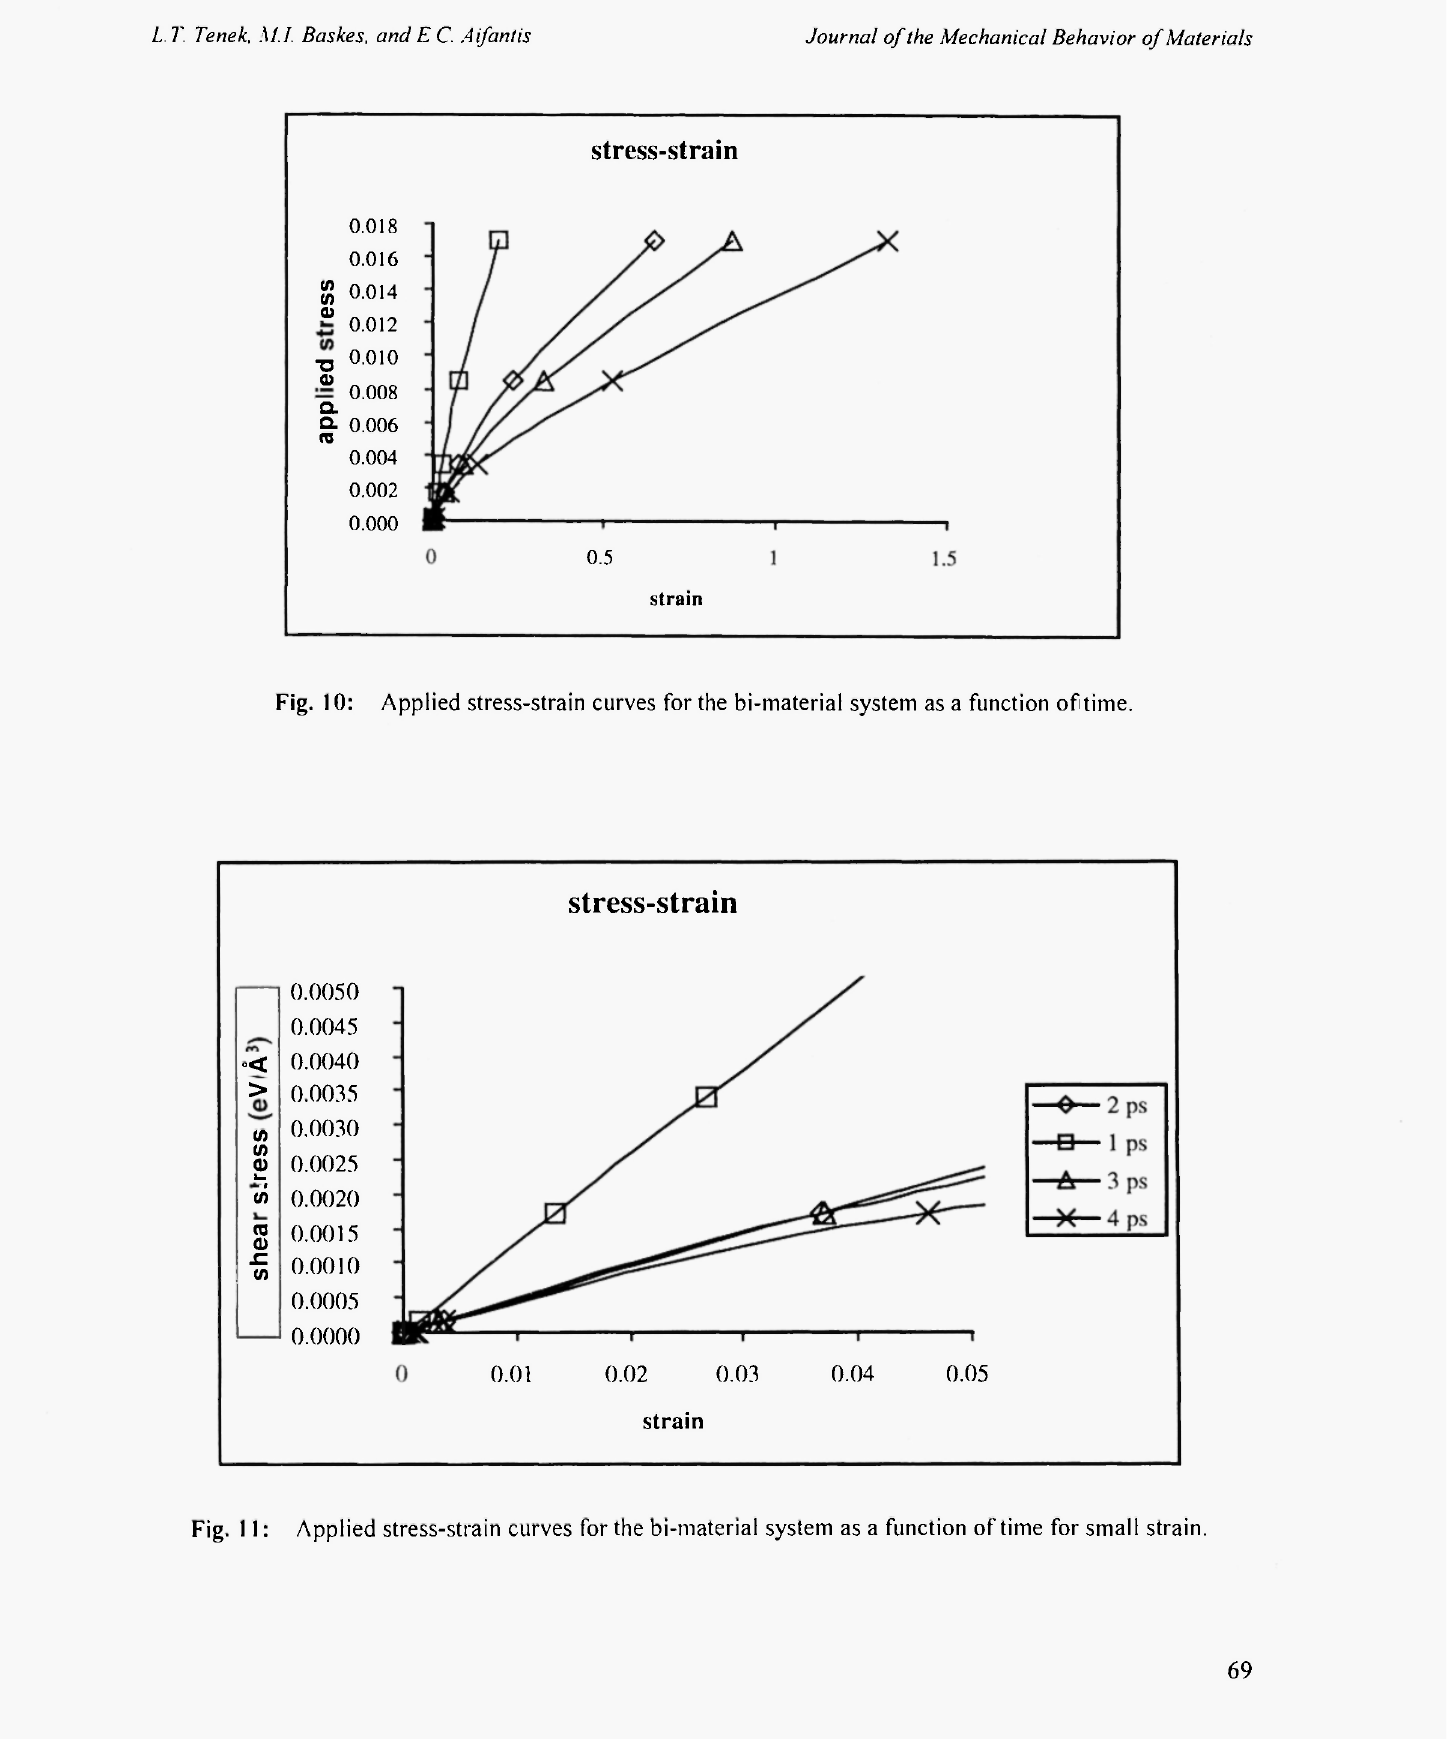
Fig. 11: Applied stress-strain curves for the bi-material system as a function of time for small